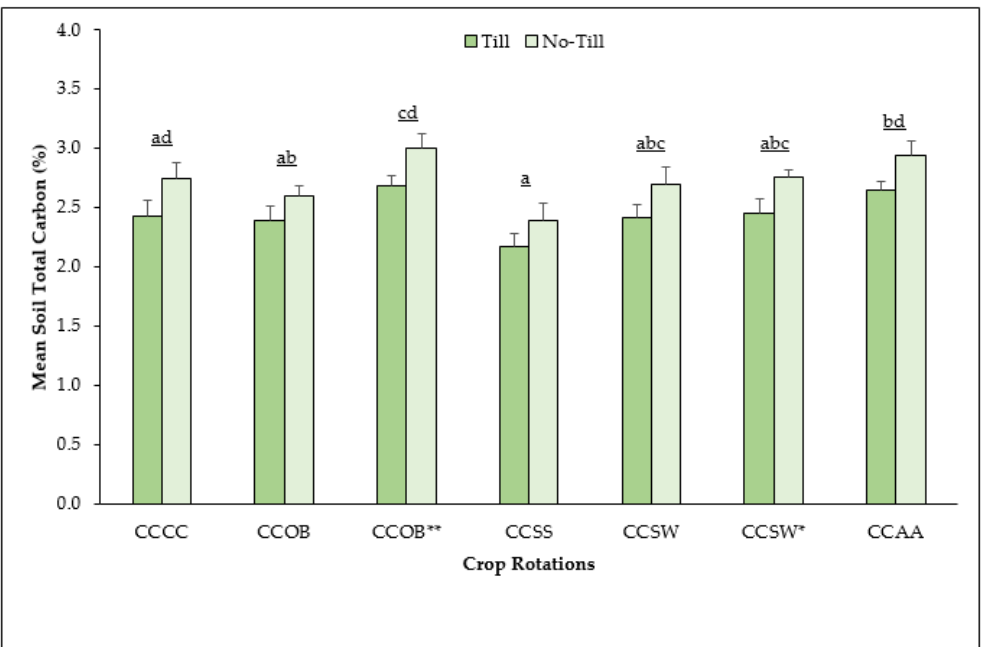
Figure 3. Topsoil total carbon concentrations in the seven cropping systems for tilled and no-tilled plots of the 2018 dataset. Different lower-case letters designate statistically significant difference ( p ≤ 0.05) between the treatments, according to pairwise Tukey tests. Error bars indicate standard error (SE) of the mean. Asterisk refer to red clover undersown to cereals, as explained in Table1.